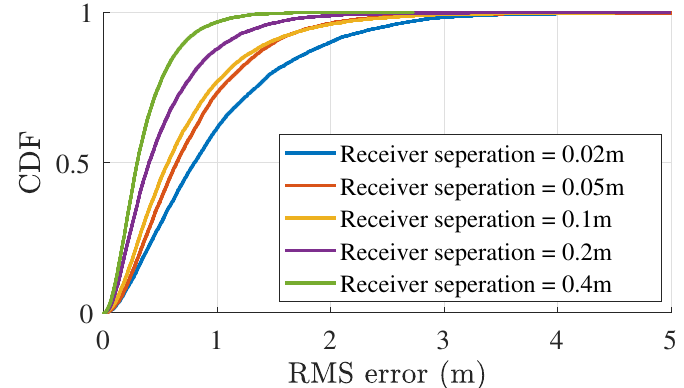
Figure 4. CDF analysis at different receiver